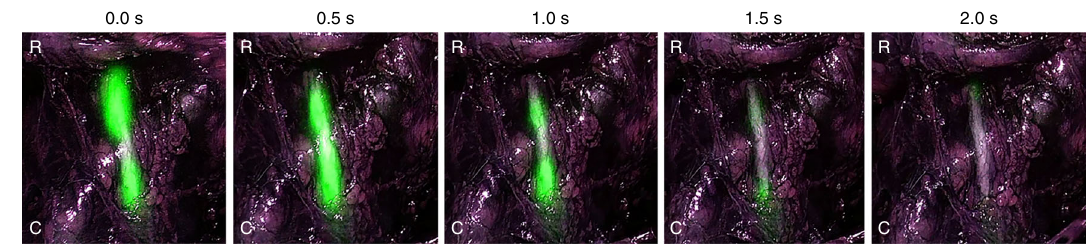
Fig. 4 Functional assessment of ureter fl ow and patency with ZW800-1 (acquired using the Olympus ®